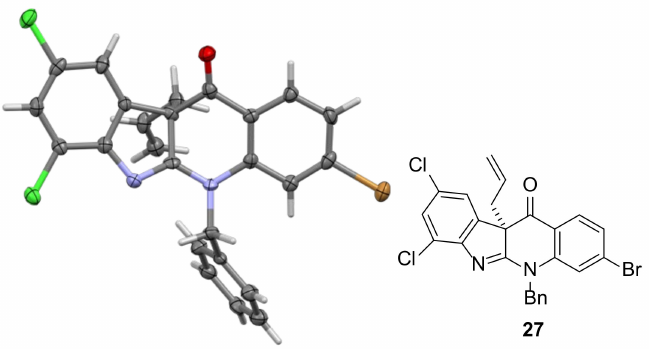
Figure 1. A view of the X-ray crystal structure of 27 (ellipsoids drawn at the 50 % probability level) used to confirm its